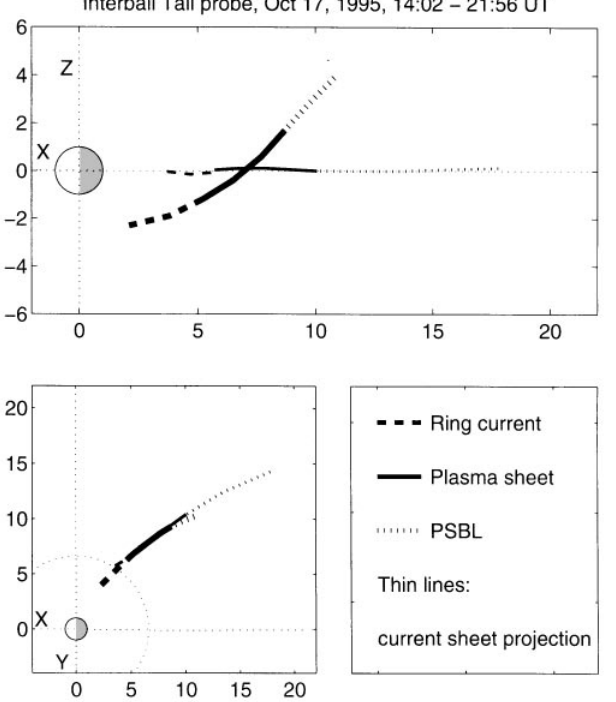
Fig. 11. The trajectory of Interball in GSM coordinates during the time of the spectrogram in Fig. 10. The thin lines show the projec- tions to the current sheet along the geomagnetic field lines according to the Tsyganenko model